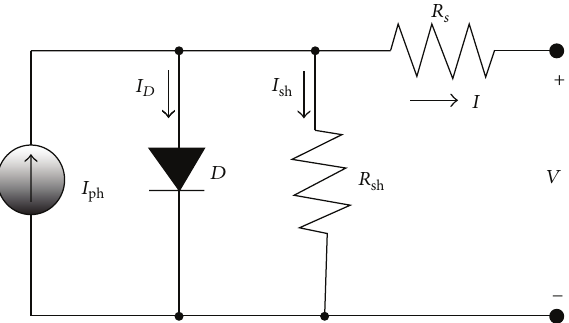
Figure 1: Single-diode-equivalent circuit model of solar cell.